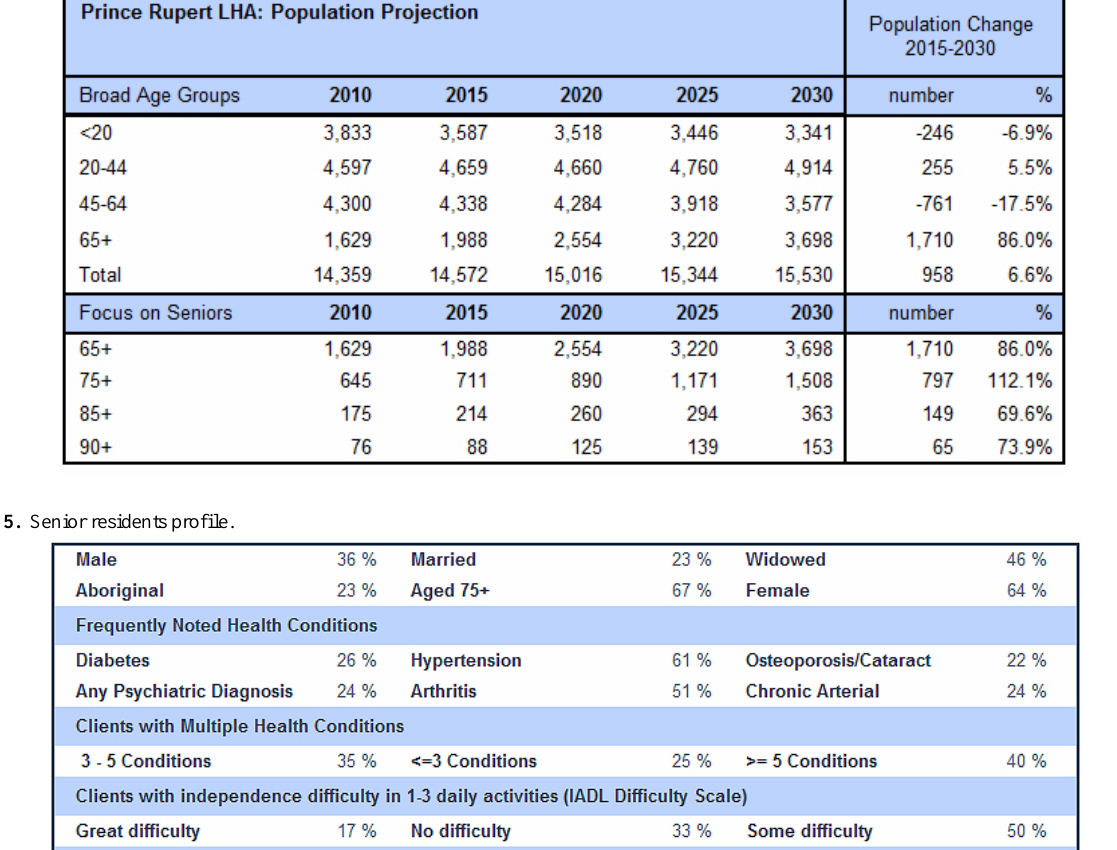
Figure 14. Population projection.